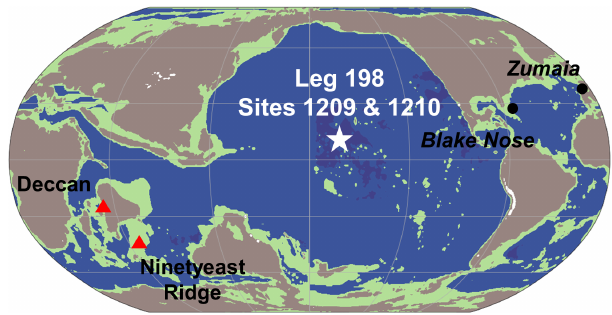
Figure 1. Location of ODP Leg 198 Sites 1209 and 1210 at Shatsky Rise at 69Ma (star) in the tropical Pacific (Scotese and Wright, 2018). Deccan and Ninetyeast Ridge are shown as red triangles. Location of Zumaia (Batenburg et al., 2012, 2014) and Blake Nose (MacLeod et al., 2001) records are shown as black circles. Shad- ing indicates land above 0m (brown); land above 6km (white); and ocean settings with water depths greater than 4km (dark blue), be- tween 4km and 120m (blue), and above 120m